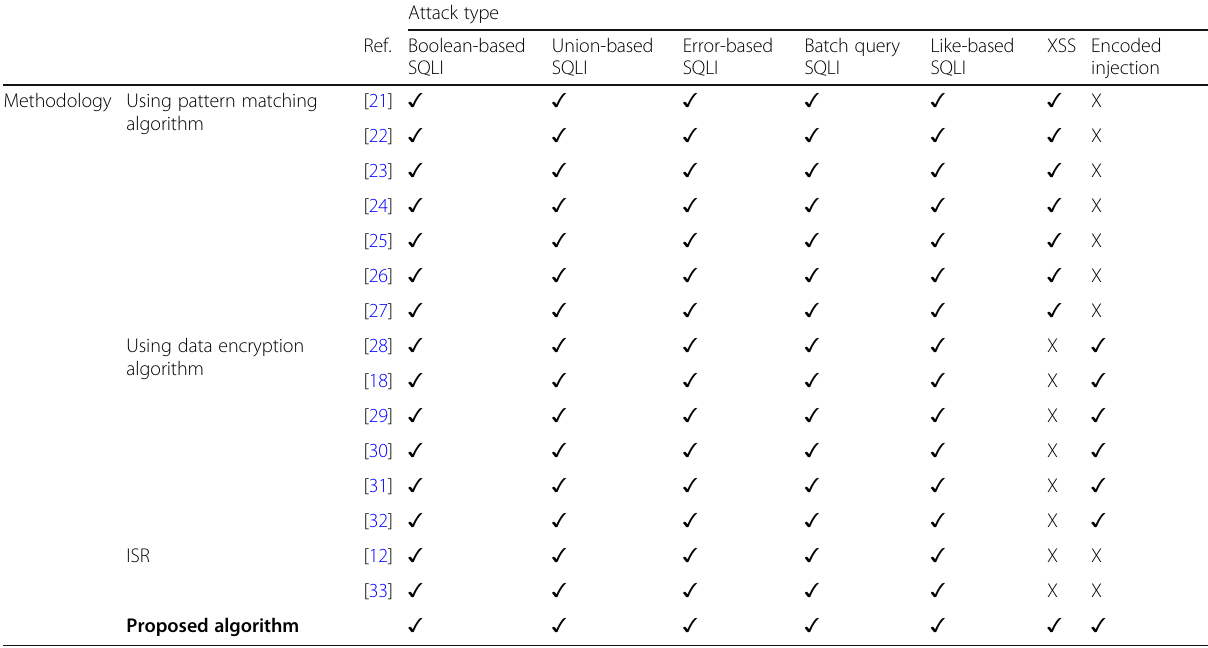
Table 5 Results of existing works vs proposed technique